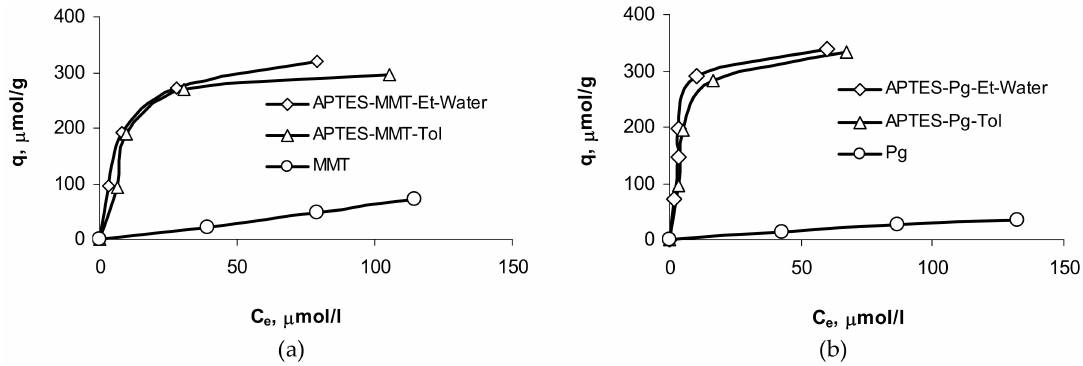
Figure 7. Adsorption of U(VI) on pristine and APTES-modified clay minerals: ( a ) montmorillonite, ( b )